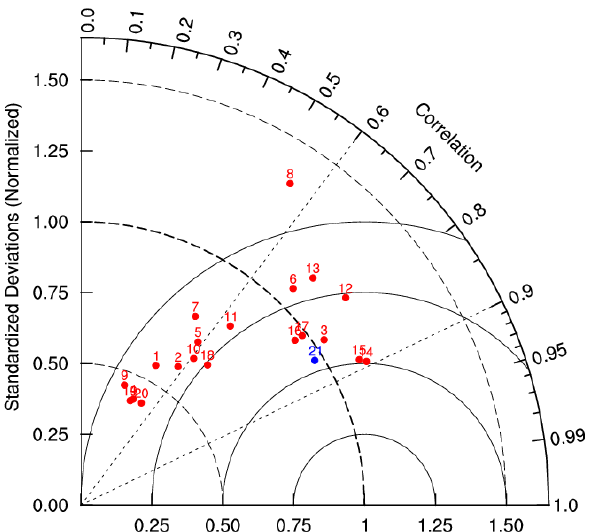
Figure 1. Spatial correlation and standard variance ratios be- tween observed and simulated winter (DJF – December–January– February) mean SWE during 1980–2005. The numbers 1–20 refer to the model names in Table 1. The number 21 indicates the multi- model ensemble. The vertical axis indicates the standard deviation ratios, and the numbers along the arc are the spatial correlation.